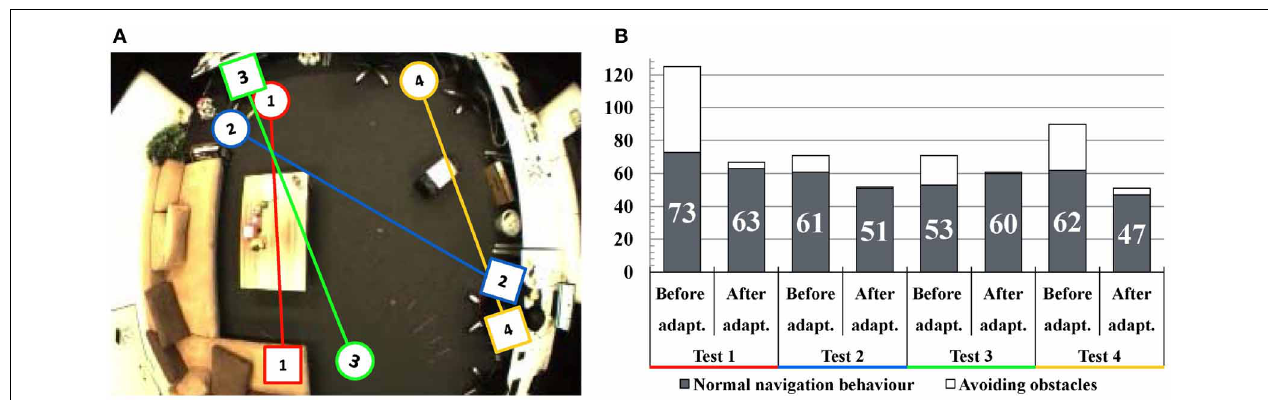
FIGURE 8 | Experiments of map adaptation through interaction with obstacles. (A) Test scenarios of four navigation experiments. The circles denote the robot’s starting positions and the squares denote the target positions. (B) Navigation time analysis. The vertical axis shows the consumed